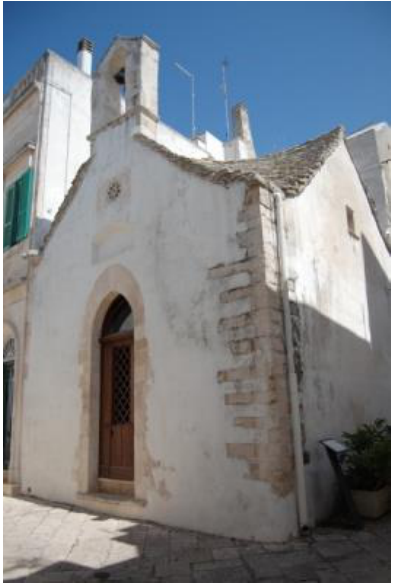
Figure 1. The Church of San Nicola in Montedoro